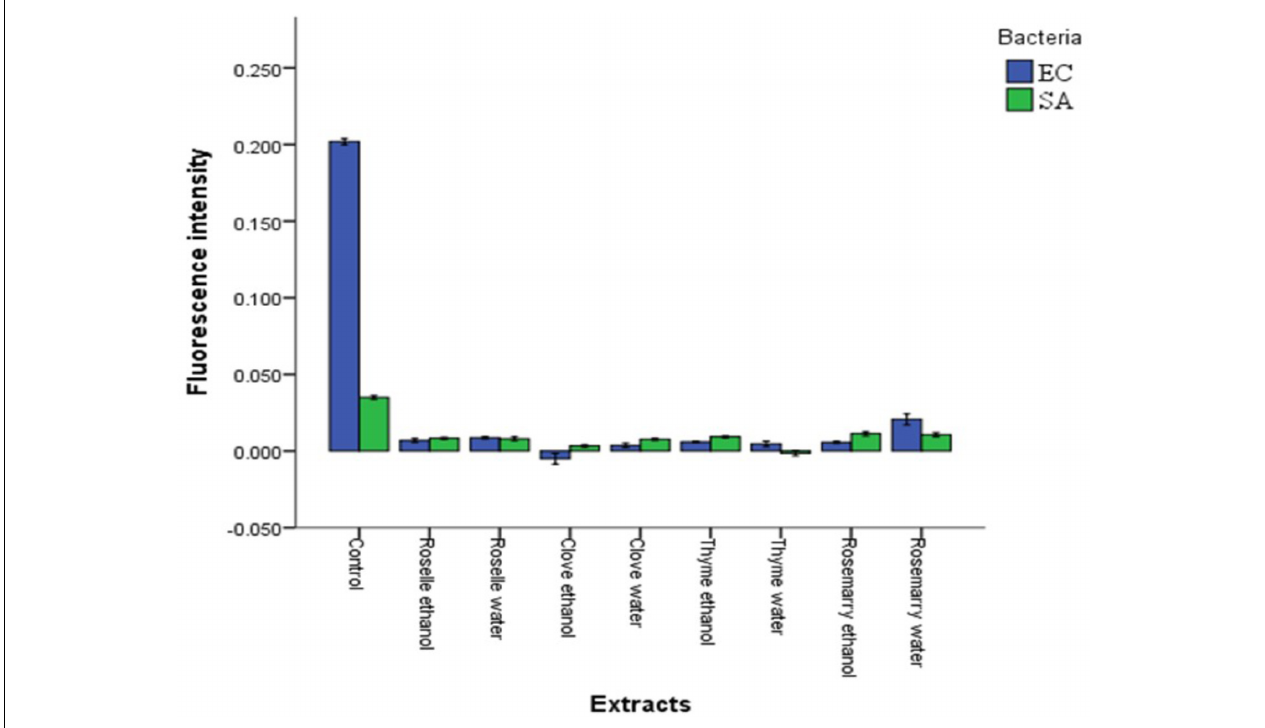
FIGURE 2 | Effects of aqueous and ethanolic extracts of Roselle, Clove, Rosemary, and Thyme on the cytoplasmic pH (pH in x t ) of Escherichia coli (EC) and Staphylococcus aureus (SA). Values represent the means of triplicate measurements ( n = 3). Bars represent the standard deviation.